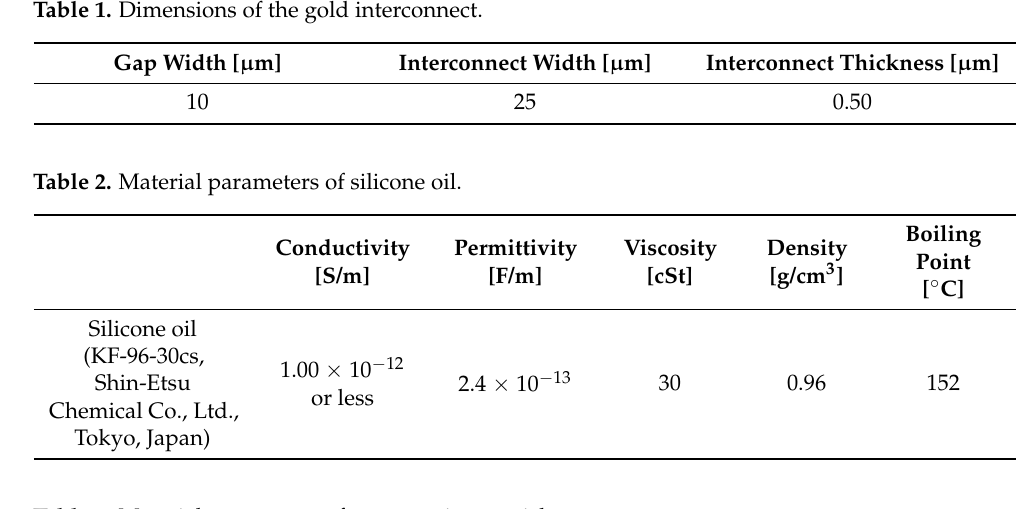
Table 3. Material parameters of copper